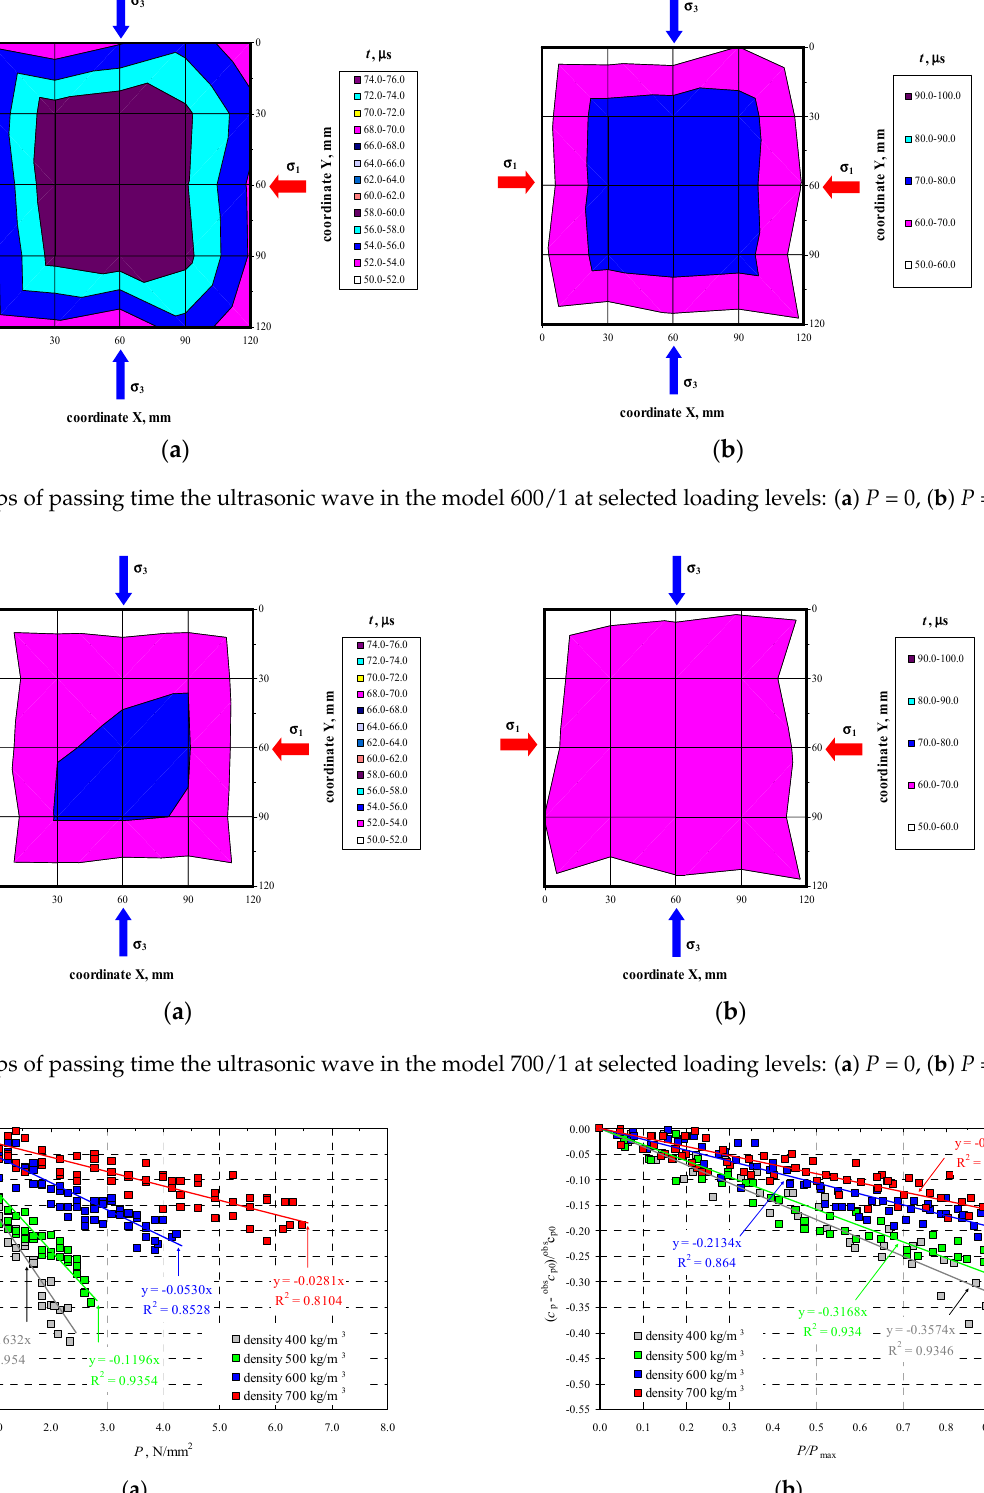
Figure 10. Results from measuring velocity of the longitudinal ultrasonic wave: ( a ) relative change in velocity of longitudinal wave as a function of compressive stress, ( b ) relative change in velocity of longitudinal wave as a function of relative compressive stresses.